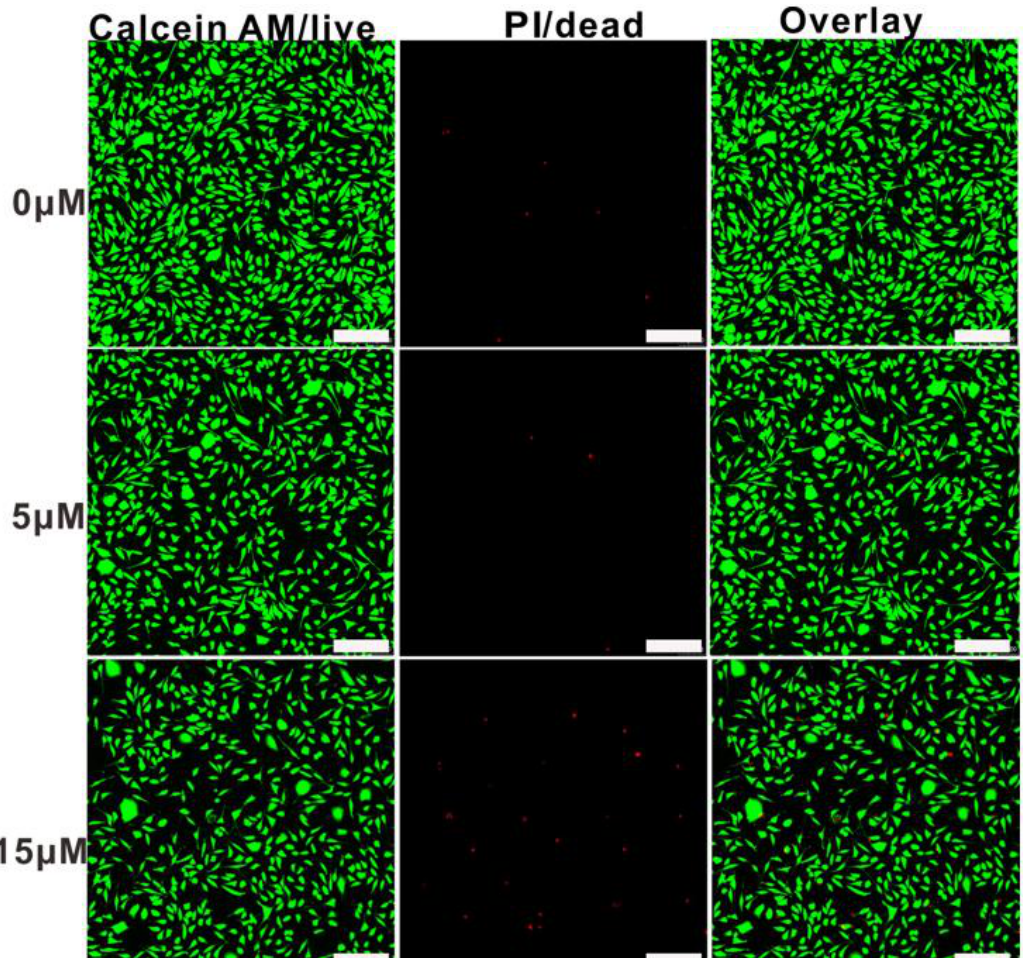
Figure 11. Confocal laser scanning microscopy (CLSM) images of L929 cell viability assays with different concentrations for 24 h , the cells were stained with Calcein-AM ( green ) and treated with PI ( red ) (scale bars: 200 μm) .